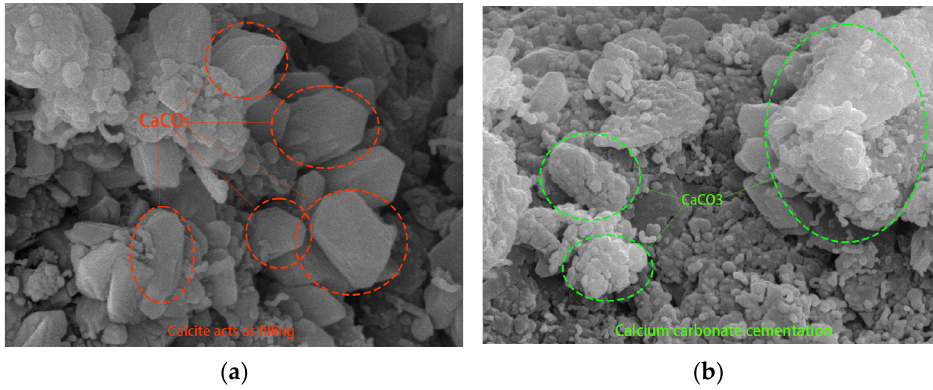
Figure 6. Micromorphology of sand soil after treatment: ( a ) filling pore; ( b ) cementation.